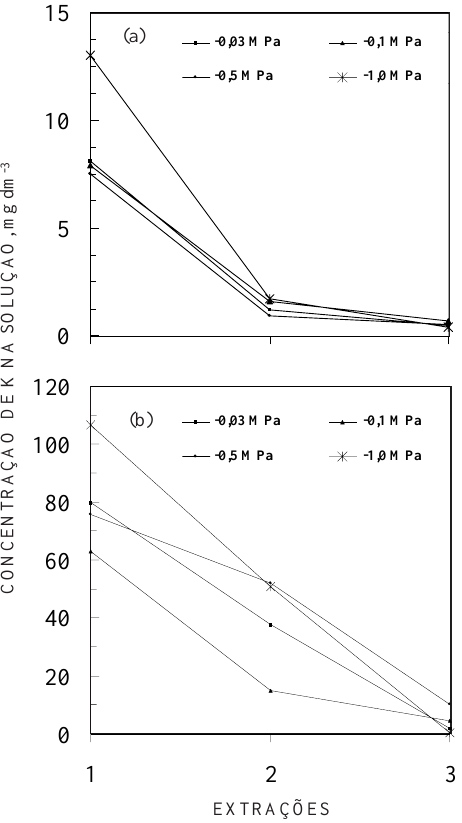
Figura 2. Esgotamento de potássio na solução do solo no tratamento com 15 mg dm -3 (a) e 121 mg dm -3 (b) de K, considerando a disponibi- lidade de água no solo e a aplicação de